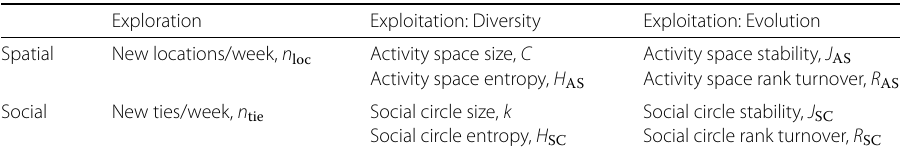
Table 3 Metrics characterising social and spatial behaviour. The metrics are defined in Sect. 3